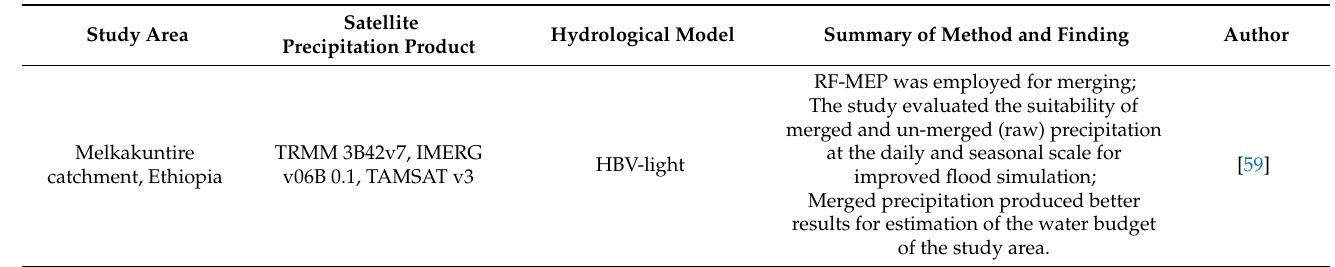
Table 3. Methodology of different studies that have applied merged precipitation products for improved hydrological